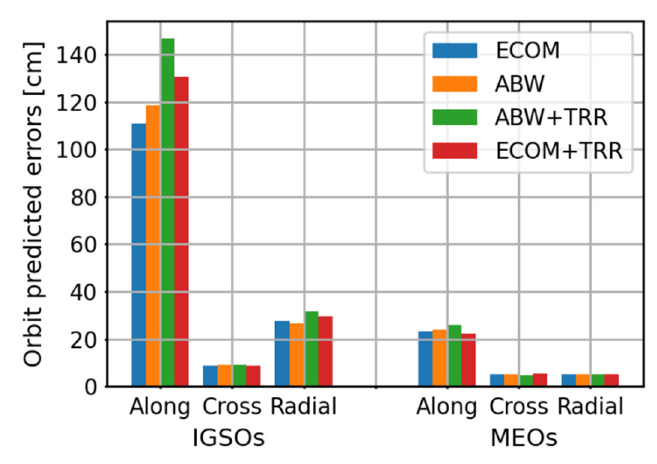
Figure 12. The accuracy of 24-h predicted orbits averaged in the BDS-2 IGSO and MEO groups from the four solutions. the four